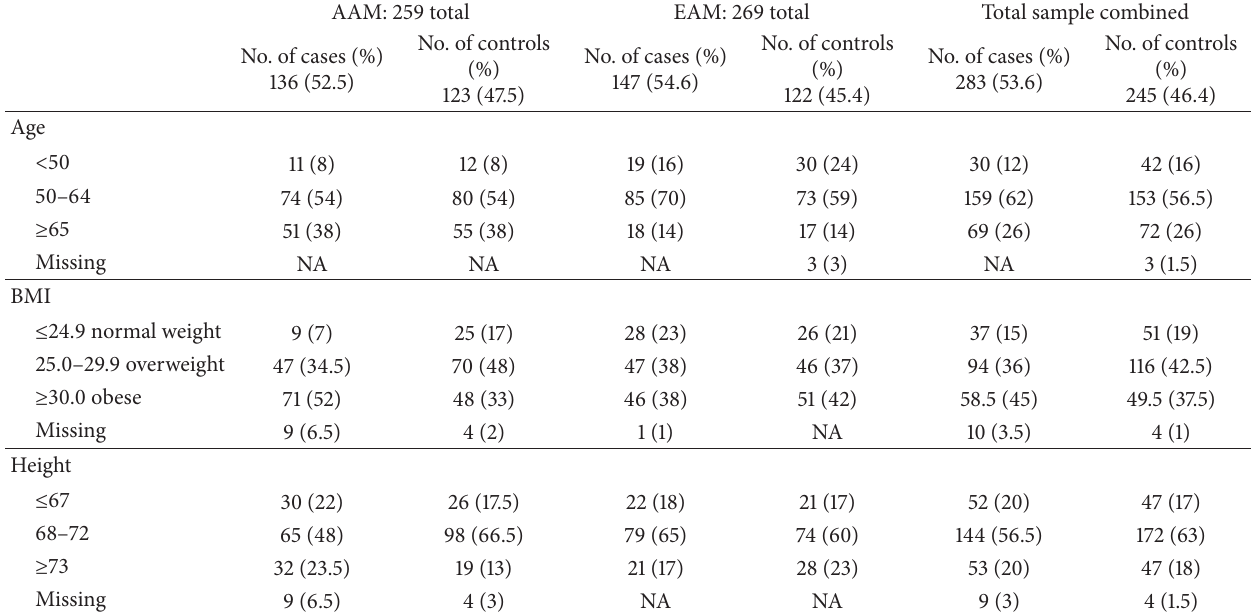
Table 1: Selected characteristics of the study participants by case/control